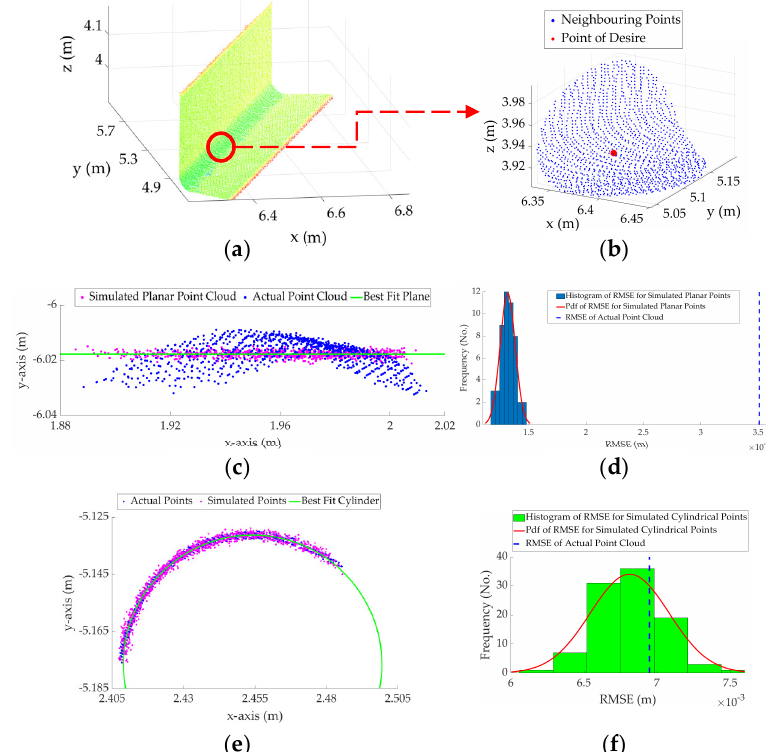
Figure 10. Sample of the planar and cylindrical hypothesis testing using Algorithm 2, applied to a neighborhood from a cylindrical surface: ( a ) point cloud; ( b ) point cloud neighborhood of a point of desire; ( c ) best-fit plane (green), actual neighborhood points (blue), and simulated neighborhood points (magenta), rotated such that the plane’s normal vector is parallel to the y axis; ( d ) distribution of the RMSE for the simulated planar points, where the RMSE of the actual neighborhood does not satisfy Equation (2), indicating that the point does not follow a planar pattern; ( e ) best-fit cylinder (green), actual neighborhood points (blue), and simulated neighborhood points (magenta), rotated such that the cylinder’s axis is parallel to the z axis; and ( f ) distribution of the RMSE for the simulated cylindrical points, where the RMSE of the actual neighborhood satisfies Equation (2), indicating that the point follows a cylindrical pattern. Algorithm 2 uses the surface geometry of the element, along with the spatial uncer- tainty of the points, to simulate a probability distribution of the RMSE if the points were to follow the hypothesized geometry. The point will be designated to the geometry if and only if its RMSE complies with that of the simulated distribution. The use of Monte Carlo